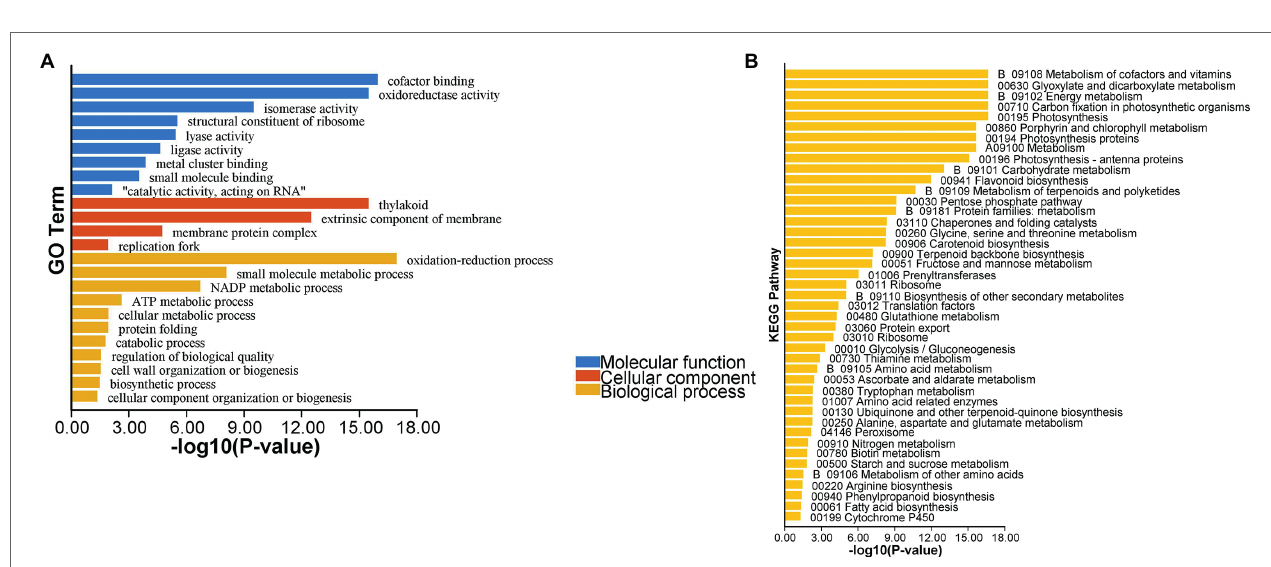
FIGURE 3 | Enrichment analysis of the differentially expressed genes (DEGs) associated with PPI networks. (A) Gene Ontology (GO) enrichment analysis of the PPI network-associated DEGs; (B) Kyoto Encyclopedia of Genes and Genomes (KEGG) enrichment analysis of the PPI network-associated